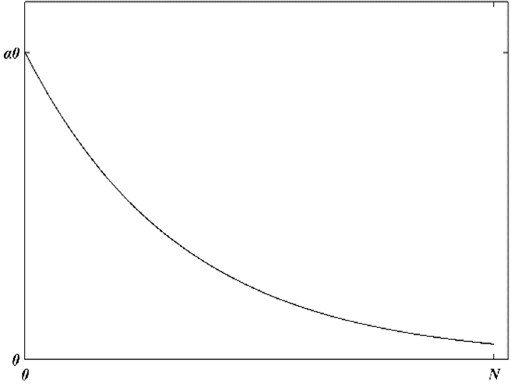
Figure 1. The adaptive adjustment procedure of α .